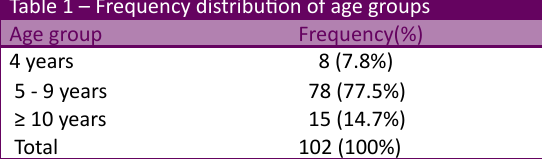
Table 3 – Frequency distribution of side effects of MPH